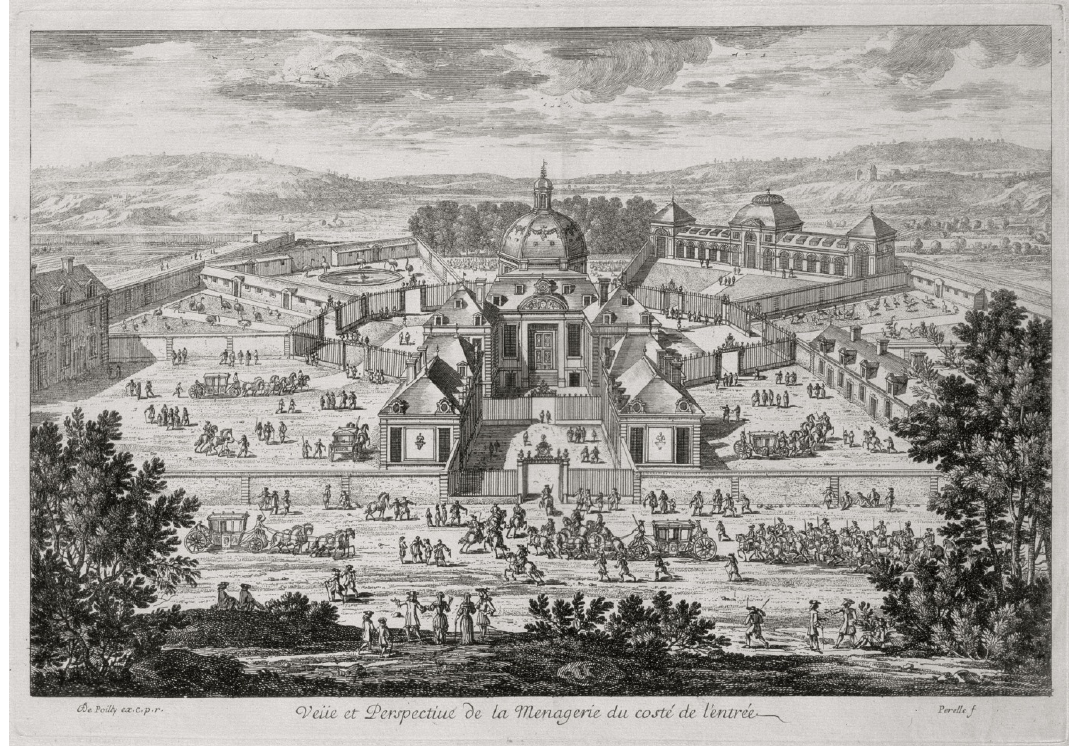
Figure 1: Louis Le Vau’s Royal Menagerie at Versailles Source: Adam Pérelle (c.1670) The View of the Menagerie from the